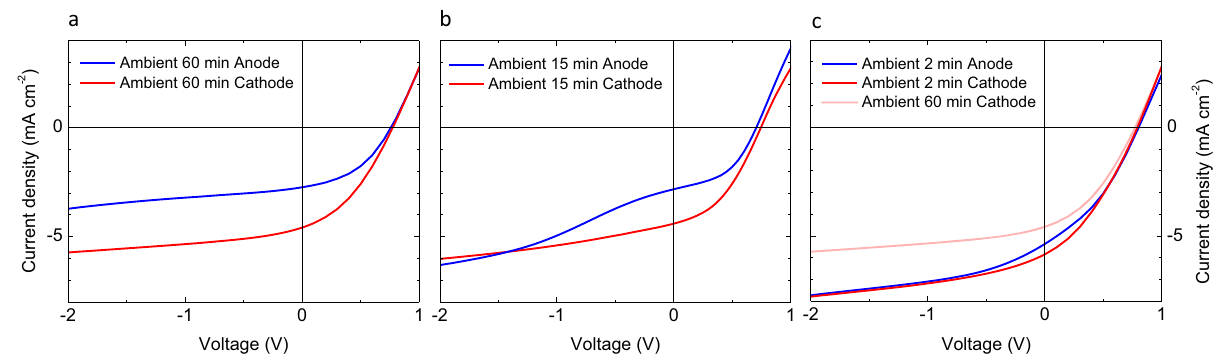
Fig. 3 Ambient exposure JV curves of laminated TQ1:PC 71 BM solar cells (illuminated under one sun conditions) deposited under inert conditions and exposed to ambient for a 60, b 15 and c 2